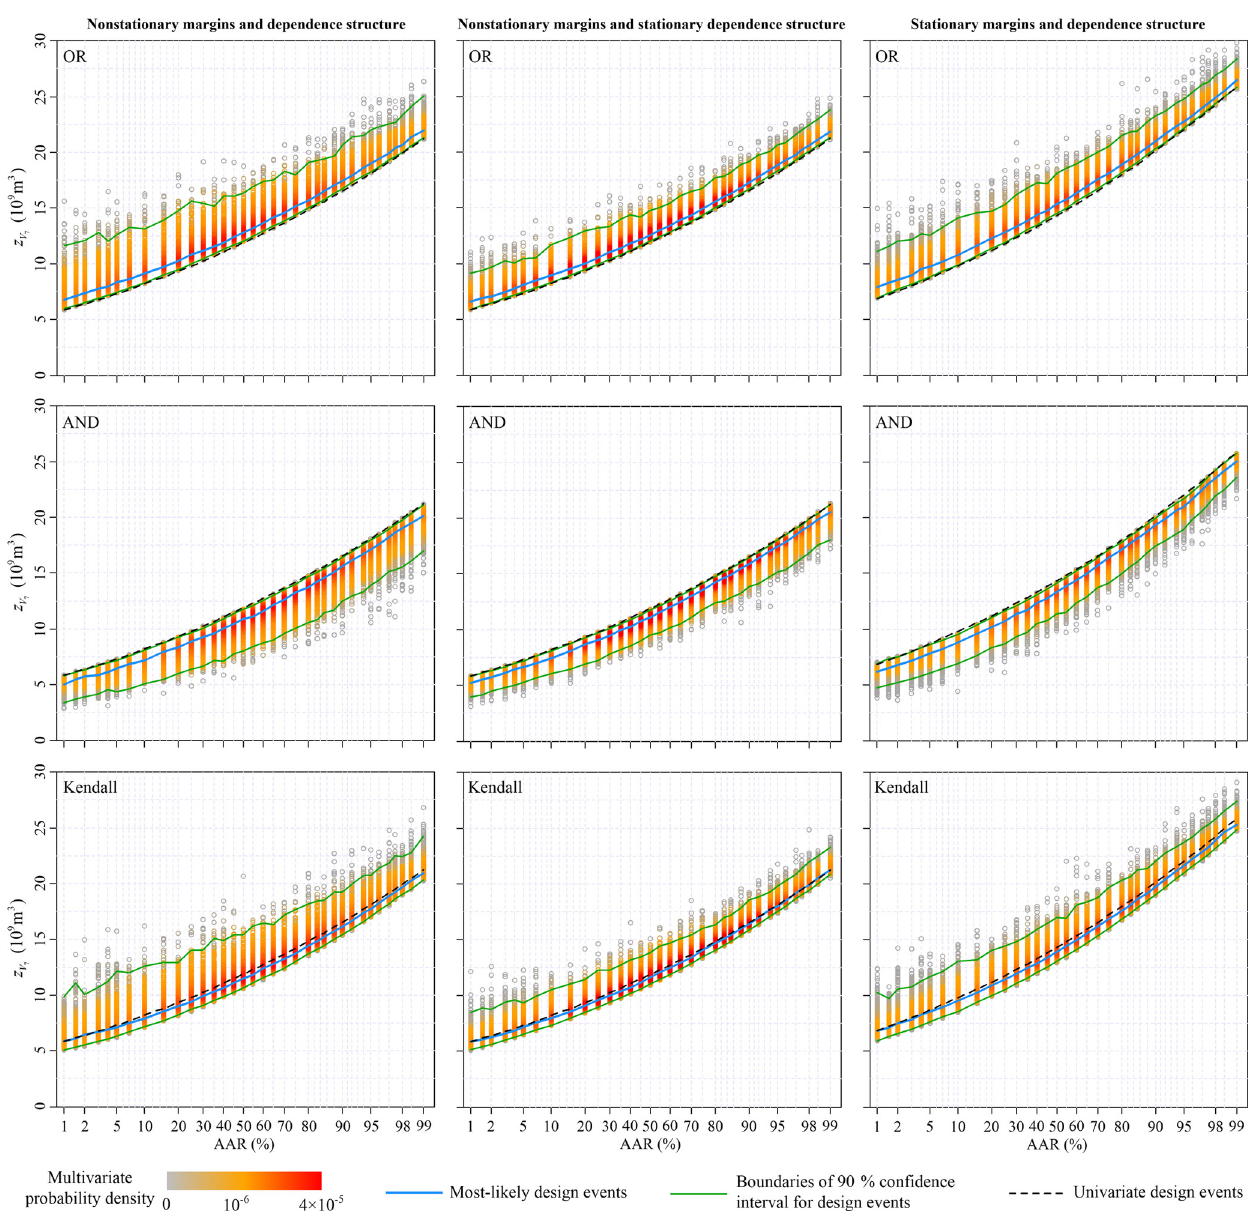
Figure 9. Design values of the 7-day flood volume for different average annual reliability (AAR) varying from 0.01 to 0.99 under three nonstationary